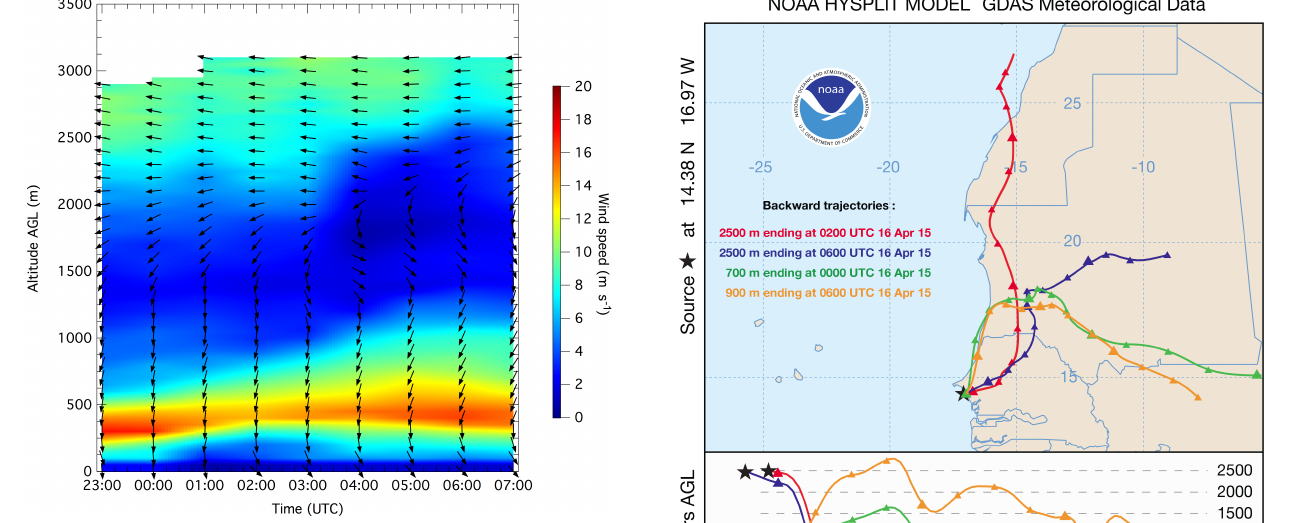
Figure 2. Time–height section of horizontal wind direction (arrows) and wind speed (color map) deduced from Doppler lidar during 15– 16 April. Leftward and downward arrows represent, respectively, easterly wind and northerly wind.